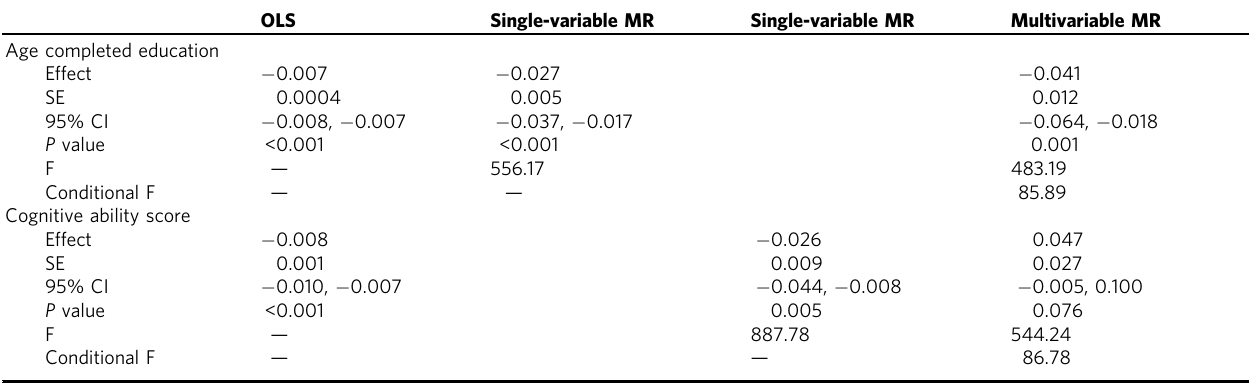
Table 1 The effect of education and general cognitive ability on current